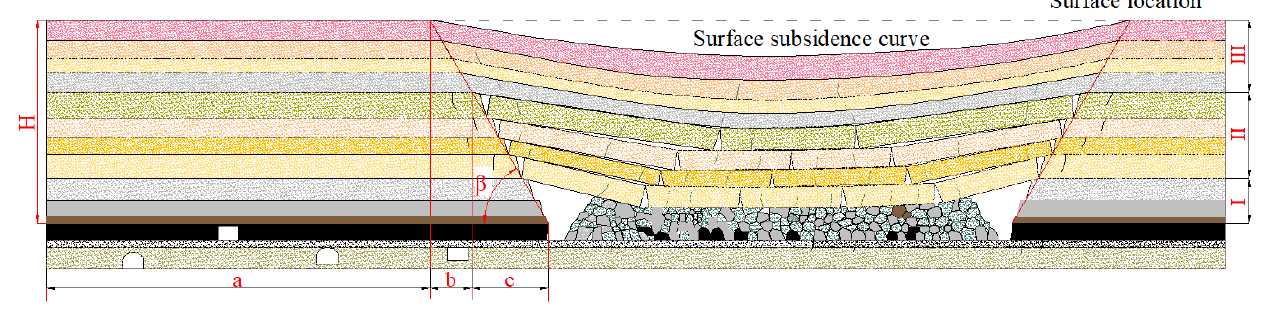
Figure 6. The profile of surface subsidence curve and mining subsidence angle.